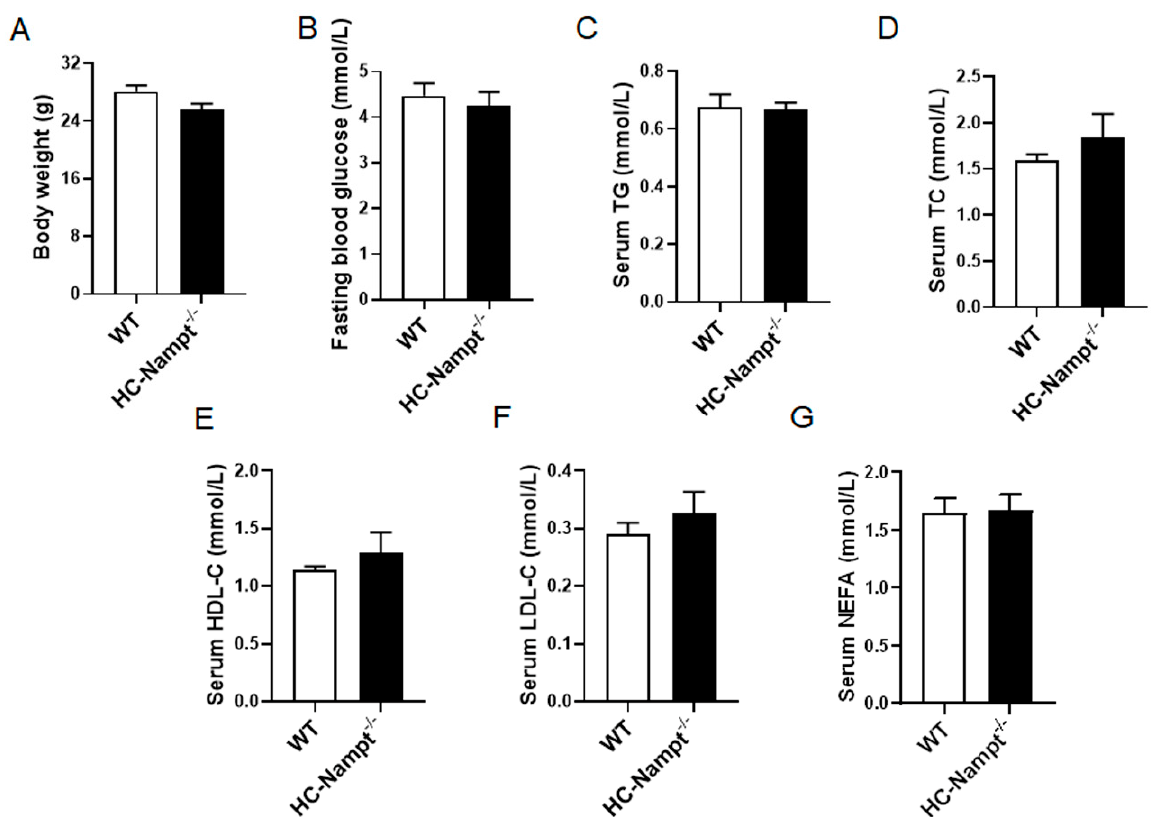
Figure 2. The effects of hepatic Nampt deficiency on body weight, fasting blood glucose, and serum lipids levels in NCD-fed mice. ( A ) Body weight of HC-Nampt -/- and WT mice. ( B ) Fasting blood glucose of HC-Nampt -/- and WT mice. ( C – G ) Serum lipids levels of HC-Nampt -/- and WT mice. TG, triglycerides; TC, total cholesterol; HDL-C, high-density lipoprotein cholesterol; LDL-C, low-density lipoprotein cholesterol; NEFA, non-esterified fatty acids. Data are expressed as the mean ± SEM. n = 7. No statistical significance between two groups by two-tailed Student’s t -test.